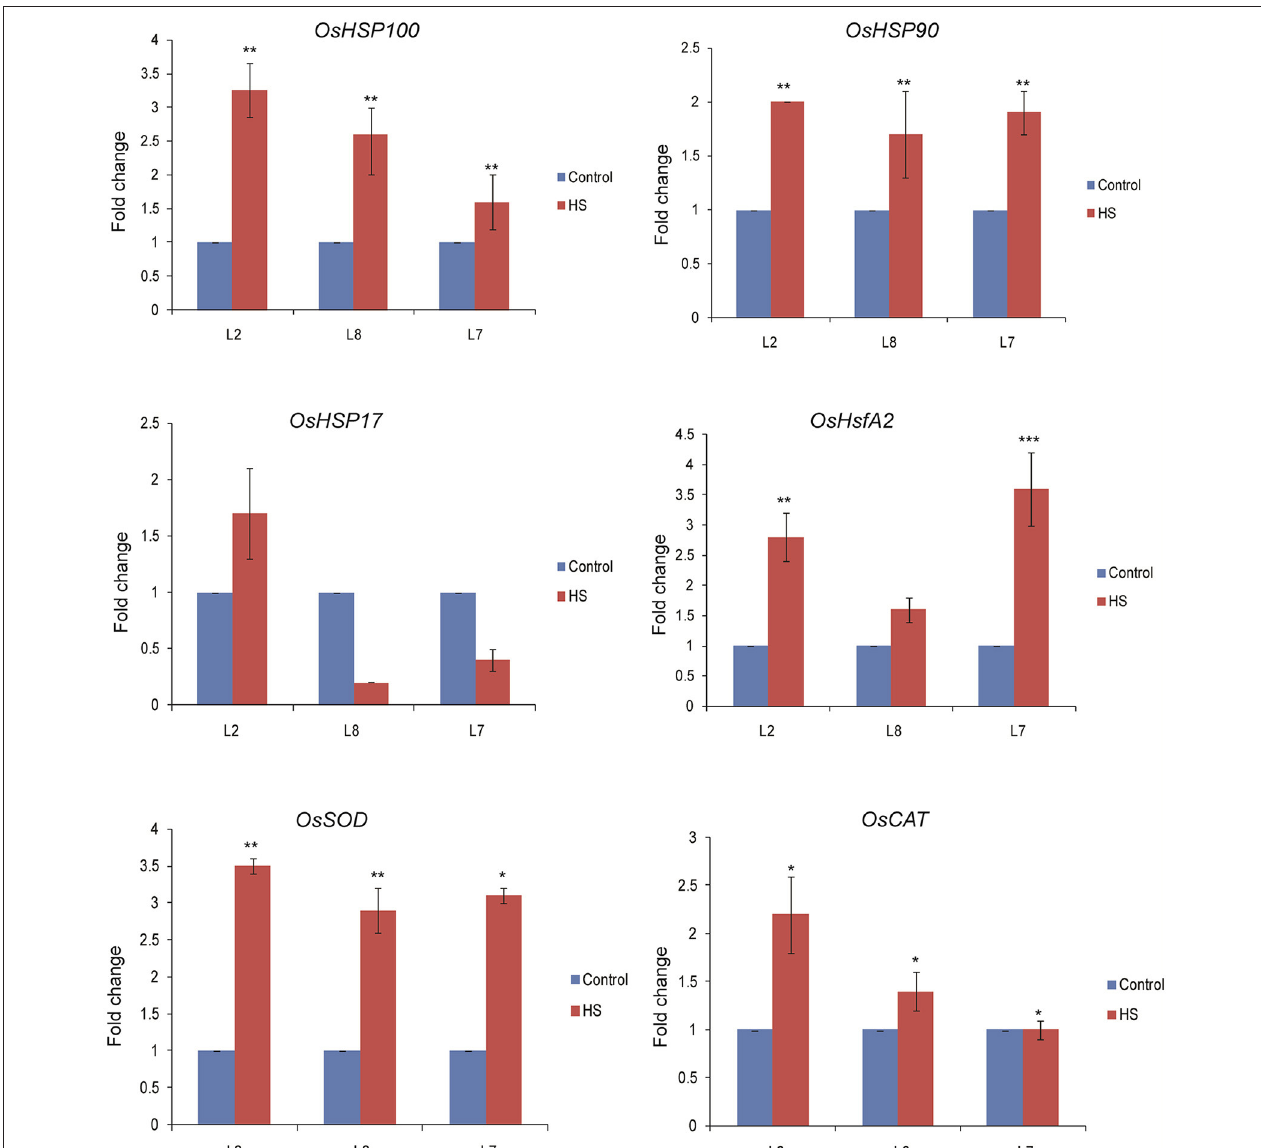
FIGURE 10 | Expression analysis of heat stress marker genes by qRT-PCR of WT and TaOBF1-5B rice transgenics under control and heat stress. Transcript levels were normalized to WT and OsUbiquitin was used as an internal control. Error bars indicate values ± SD. Asterisks on top of the error bars represent the significance levels (Students t -test; p ≤